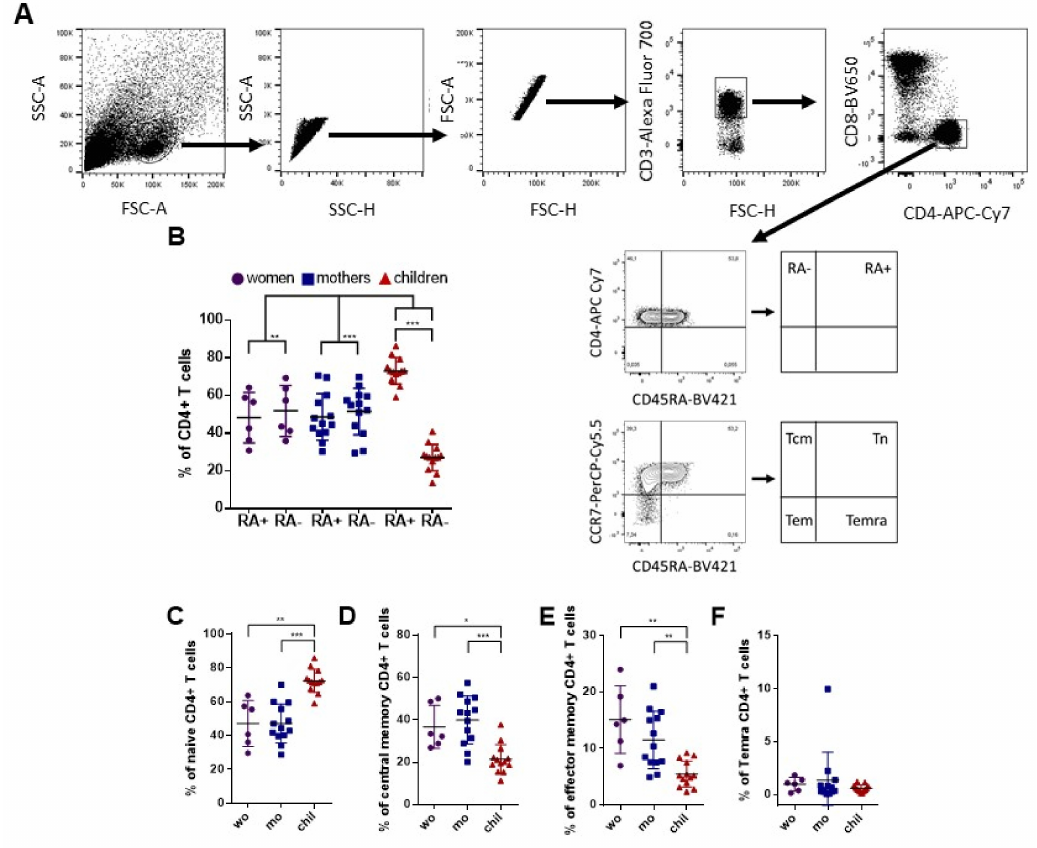
Figure 1. Subpopulations of CD4+ T cell phenotypes among individuals with a history of ZIKV infection. CD4 ZIKV-restricted responses among women (from non-pregnant women infected with ZIKV, violet circles, n = 6), mothers (from pregnant mothers infected with ZIKV, blue squares, n = 13) and children (from children born to mothers infected with ZIKV during pregnancy, red triangles, n = 13) with histories of ZIKV infection, after 6 h of in vitro stimulation with ZIKV MP. ( A ) Gating strategy for the flow cytometry plots identifying ZIKV-specific CD4+ T cells. Black arrows indicate the step-by-step analysis. ( B ) Percentages of CD4+ T cells that express CD45RA (RA+) and that do